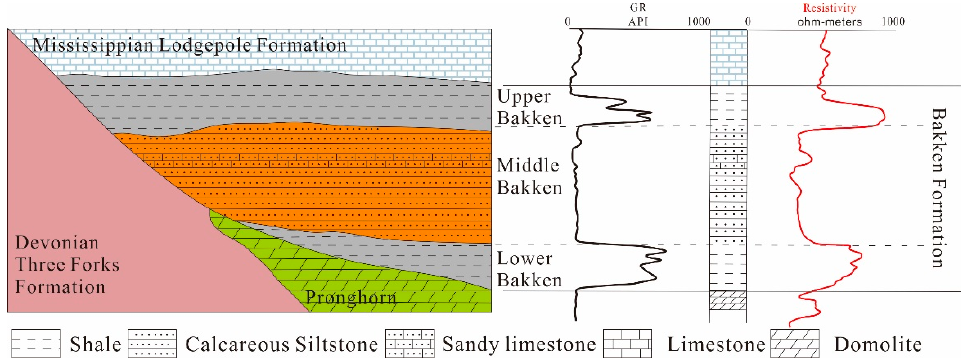
Figure 2. Basin schematic diagram and the typical log curves (modified after Liu et al.